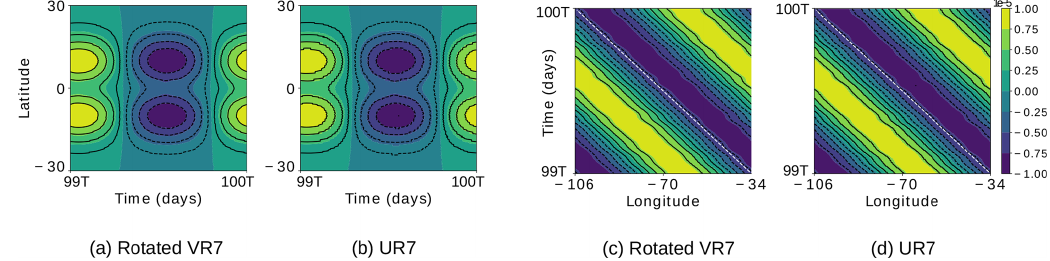
, where ω and k are the ω